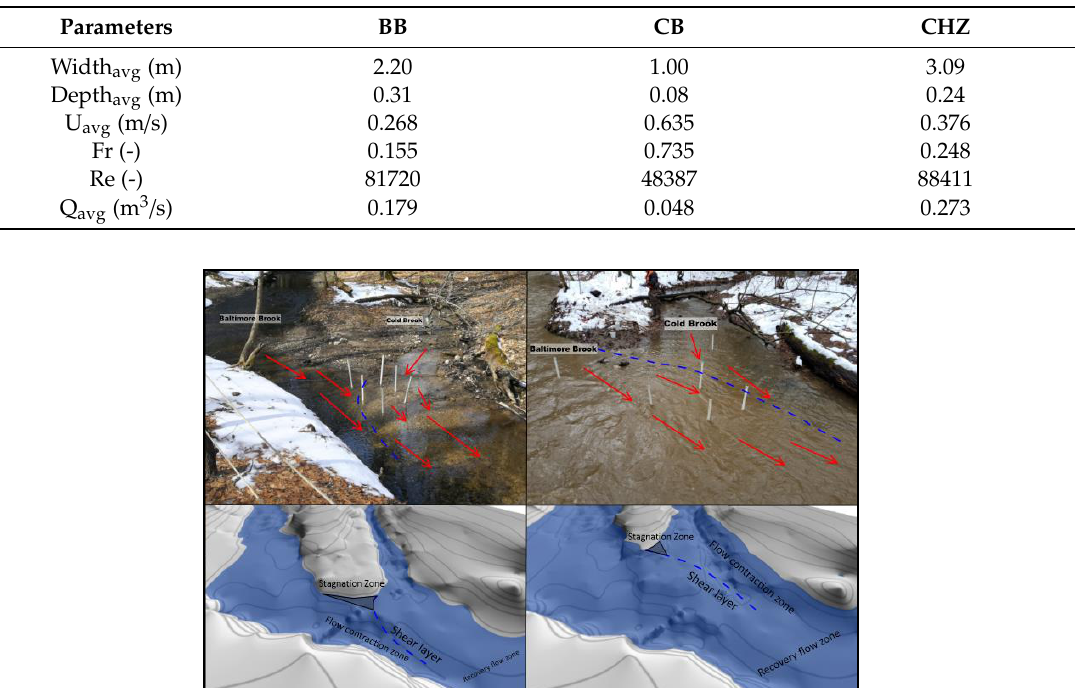
Table 3. Low flow active channel width, depth, average velocity, discharge, Froude and Reynolds numbers in BB, CB, and in the CHZ. Data for BB and CB were collected 1.5 m upstream of the junction,